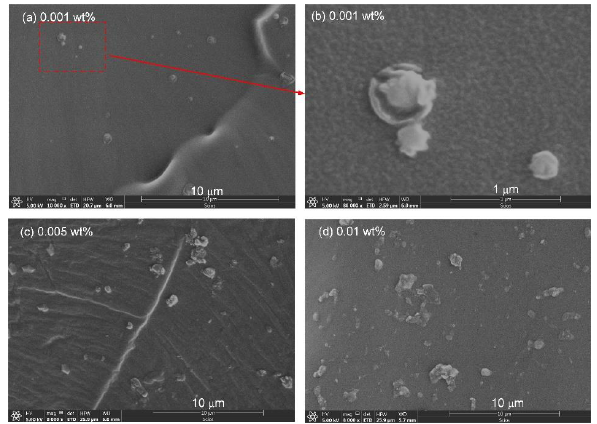
Figure 2. Scanning electron microscopy (SEM) images of di ff erent samples: ( a ) SEM of nanocomposites with graphene content of 0.001 wt %; ( b ) Enlarged SEM of ( a ); ( c ) SEM of nanocomposites with a graphene content of 0.005 wt % and ( d ) SEM of nanocomposites with a graphene content of 0.010 wt %. Graphene nanoplatelets with a lighter color can be found in each